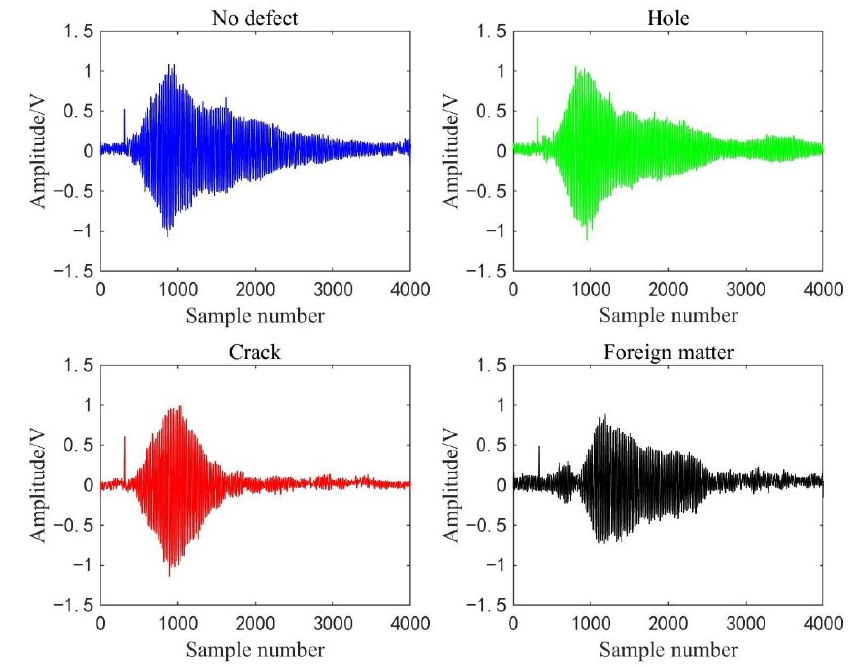
Figure 13. Four reconstruction waveforms of detection signals.